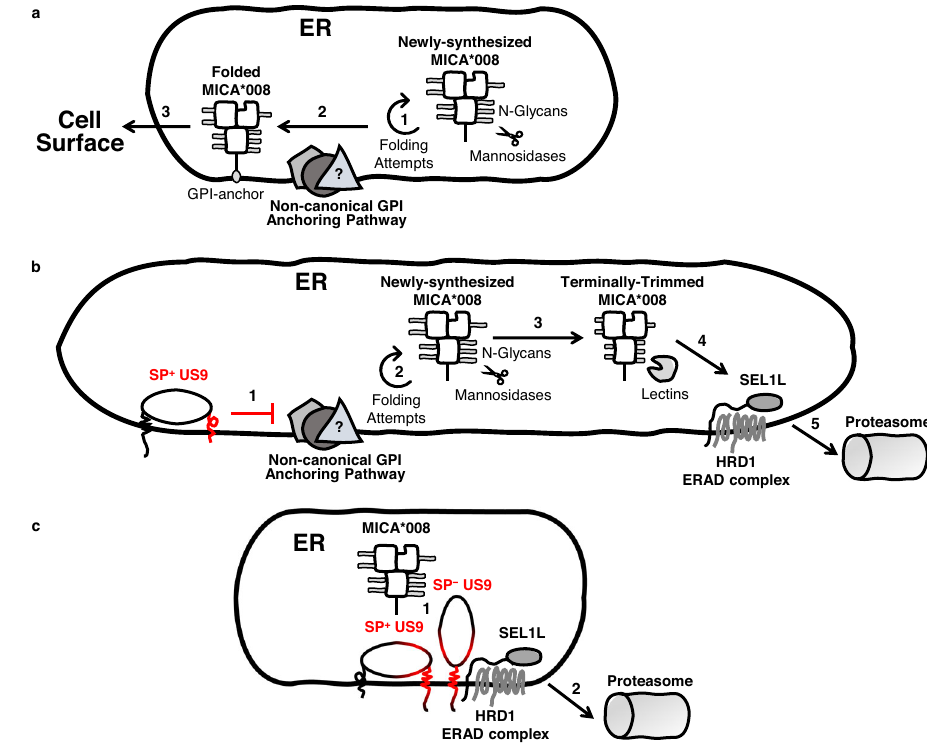
Fig. 10 Uni fi ed model for US9 function. a MICA*008 ’ s slow maturation process. Newly synthesized MICA*008 is recognized as misfolded by the ER quality control (ERQC) machinery, which retains it in the ER for repeated folding attempts and glycosylation trimming (1). Unknown factors (question mark) rescue MICA*008 from this cycle by slow delivery to the GPI-anchoring complex (2). GPI-anchored MICA*008 is recognized as properly folded, enabling its ER egress and expression on the cell surface (3). b US9 SP-dependent mode of function. The SP in the SP + US9 form (highlighted in red) interferes with the GPI-anchoring promoting factors (red line) resulting in MICA*008 maturation arrest (1). MICA*008 is retained in the ER by the ERQC machinery and undergoes repeated folding attempts and progressive glycosylation trimming (2). Eventually, MICA*008 become terminally trimmed and lectins deliver it to the SEL1L-HRD1 ER-associated degradation (ERAD) complex (3), which sends MICA*008 to proteasomal degradation (4). c US9 SP- independent mode of function. SP + US9 and SP − US9 bind MICA*008 through their luminal Ig-like domain, and SEL1L through their TM domain (domains are highlighted in red) (1). This interaction leads to SEL1L-HRD1 mediated retrotranslocation and proteasomal degradation of MICA*008 (2), with no dependence on glycosylation